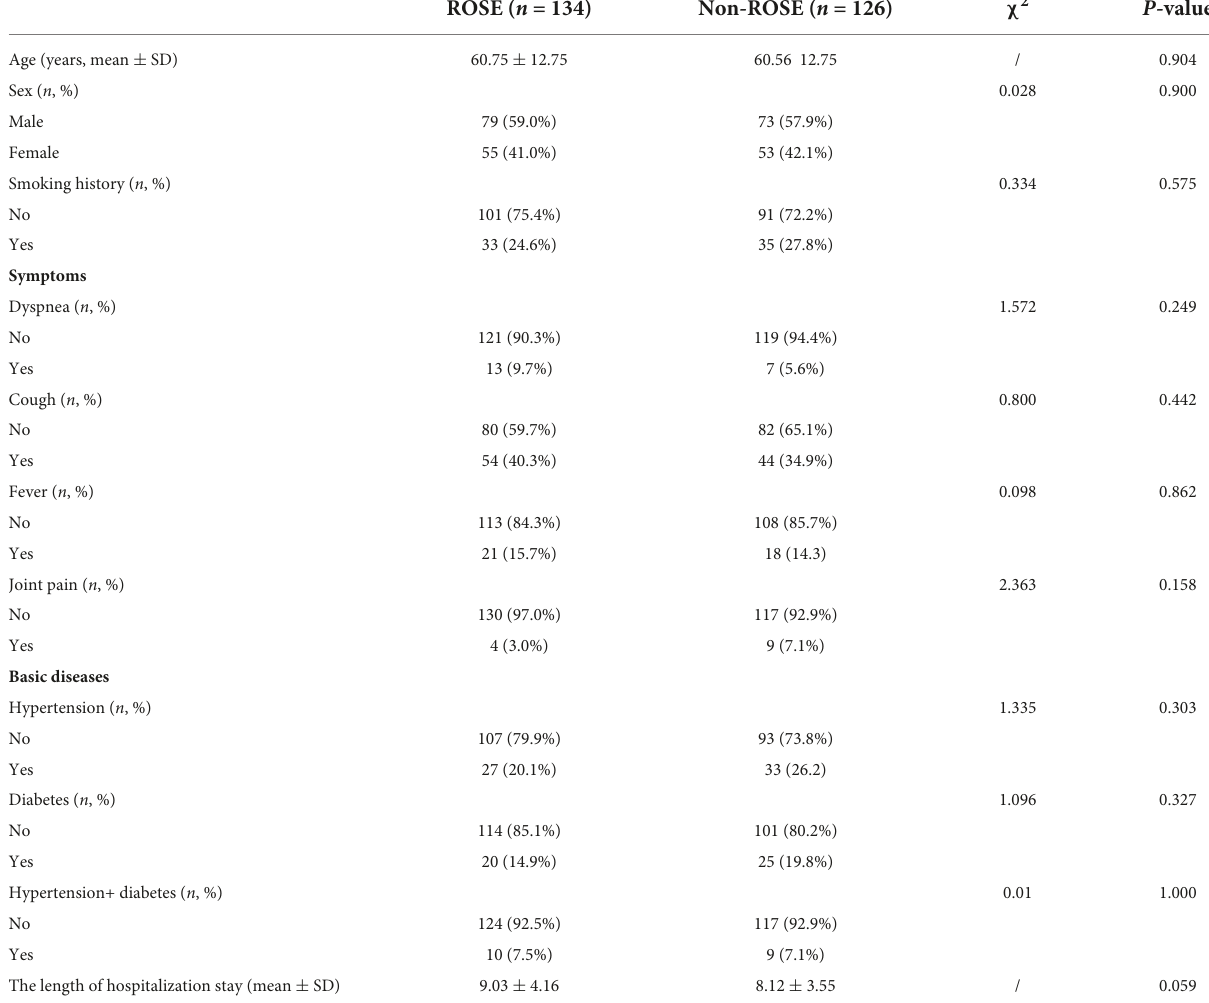
TABLE 1 Baseline characteristics of